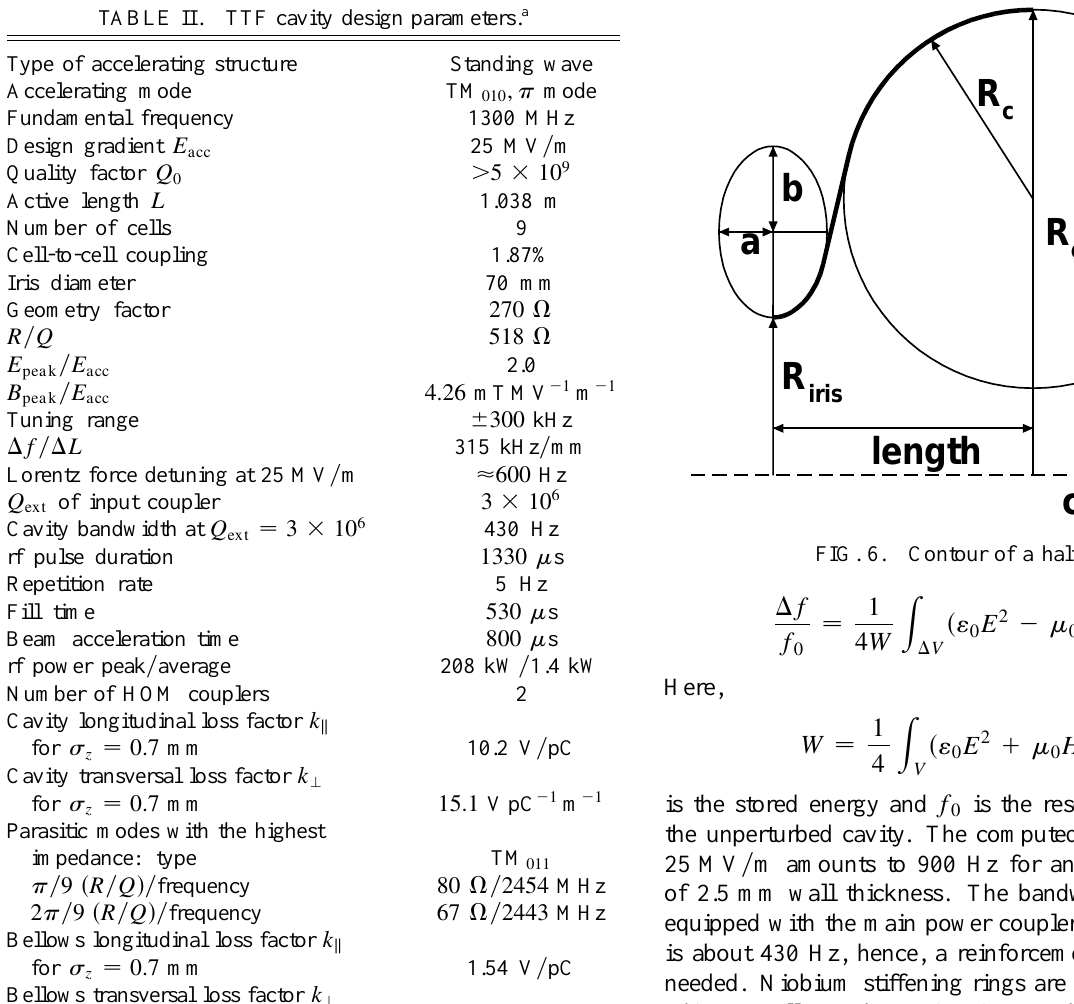
TABLE II. TTF cavity design parameters. a